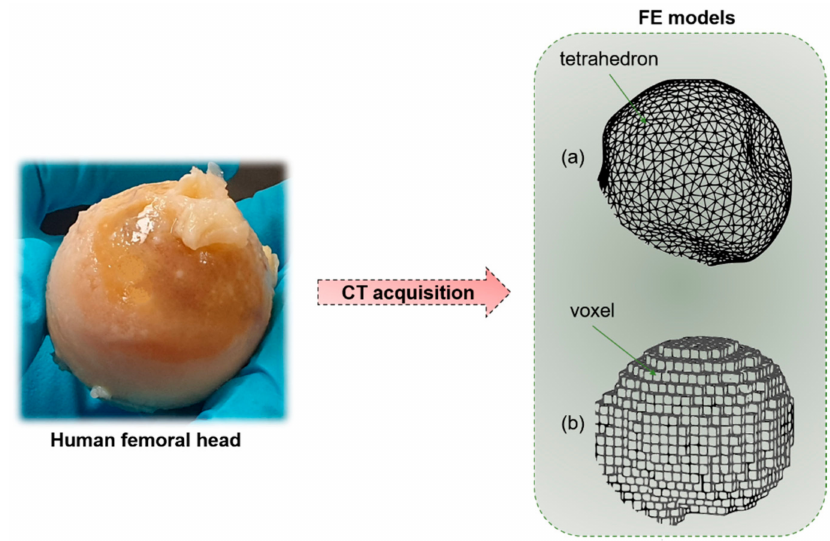
Figure 8. Starting from a human bone (e.g., femoral head), by means of CT acquisition, it is possible to obtain a macro-scale finite element (FE) model of the sample. ( a ) Geometry-based FE models with tetrahedral elements. ( b ) Voxel-based FE model with hexahedral elements.